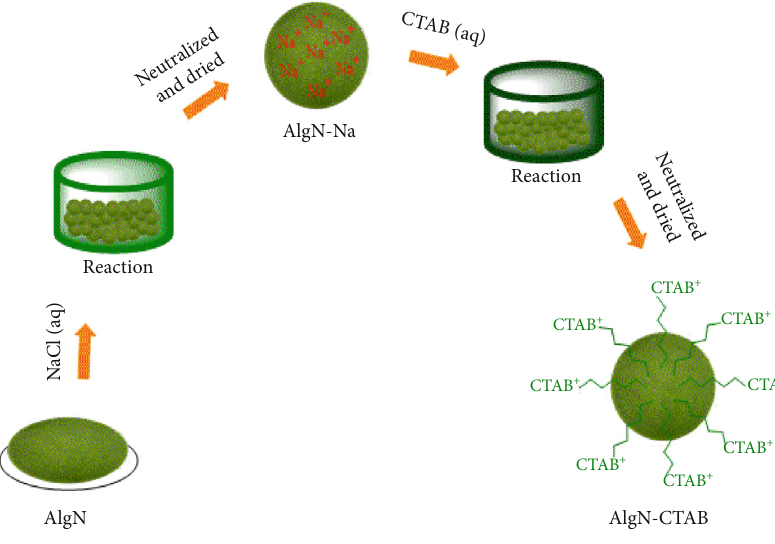
Figure 1: Adsorbent AlgN-CTAB preparation